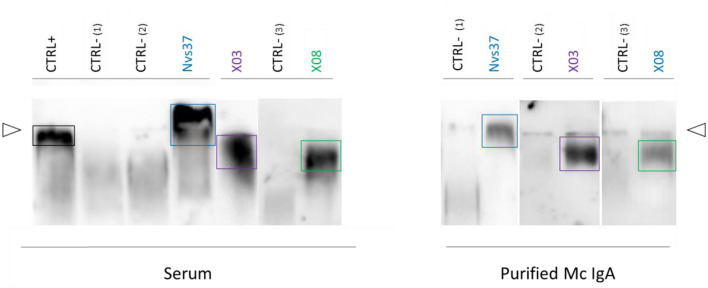
Lysoglucosylceramide (LGL1) is specifically recognized by subsets of purified monoclonal IgAs. LGL1-specific immunoblotting assays were performed as described in the Materials and Methods section (7, 27, 28). Samples of serum (left) or purified monoclonal IgAs (right) were first submitted to agarose gel electrophoresis; then, the gels were blotted onto LGL1-saturated membranes. After blocking for 1 h, membranes were incubated with anti-human IgA horseradish peroxidase (HRP)-conjugated secondary antibody, then washed and revealed by chemiluminescence. The positive control (CTRL+, left) was a sample of serum from a patient known to have LGL1-specific IgAs. Negative controls (CTRL–) were samples of serum without LGL1-reactive IgAs (one from a healthy volunteer, two from patients). The lines of sample deposit are indicated by white arrowheads. The positive signals characteristic of LGL1-reactive Igs are encircled. Patterns of migration may differ for serum and purified monoclonal IgAs because serum may contain both monoclonal and polyclonal LGL1-reactive IgAs.